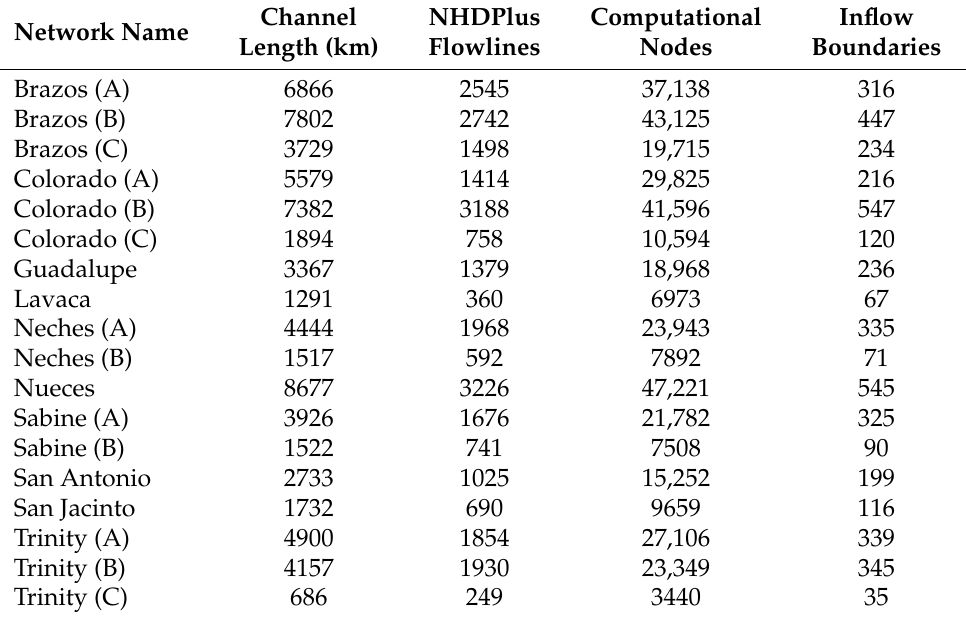
Table 1. Topological information of major river networks in the Texas–Gulf watershed (HUC 12) and network dividend in each river